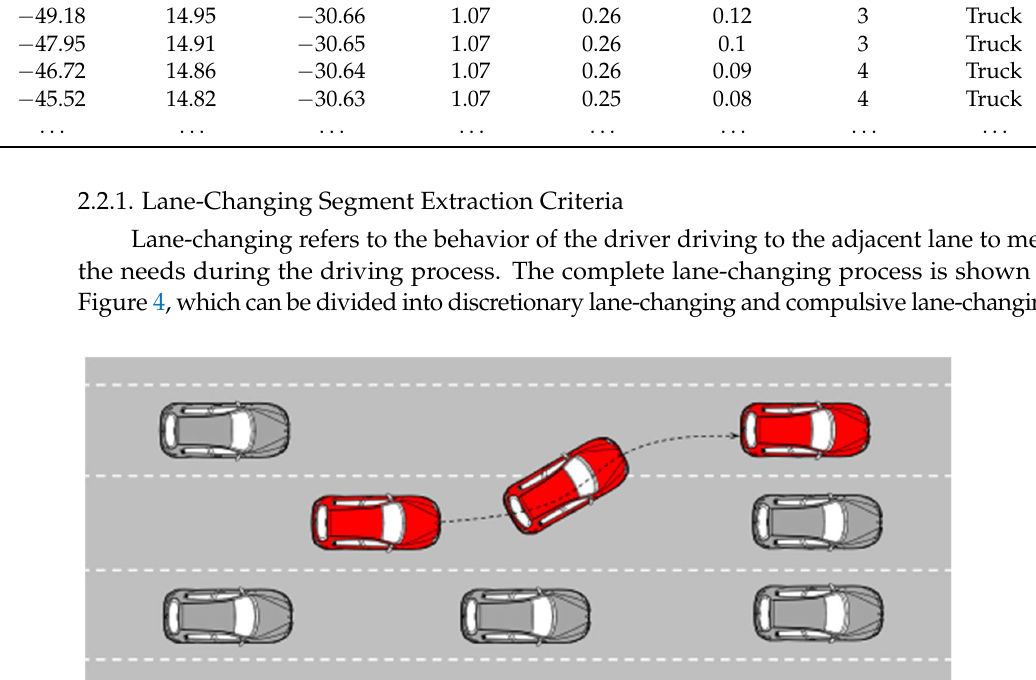
Table 1. Vehicle running track data (part).